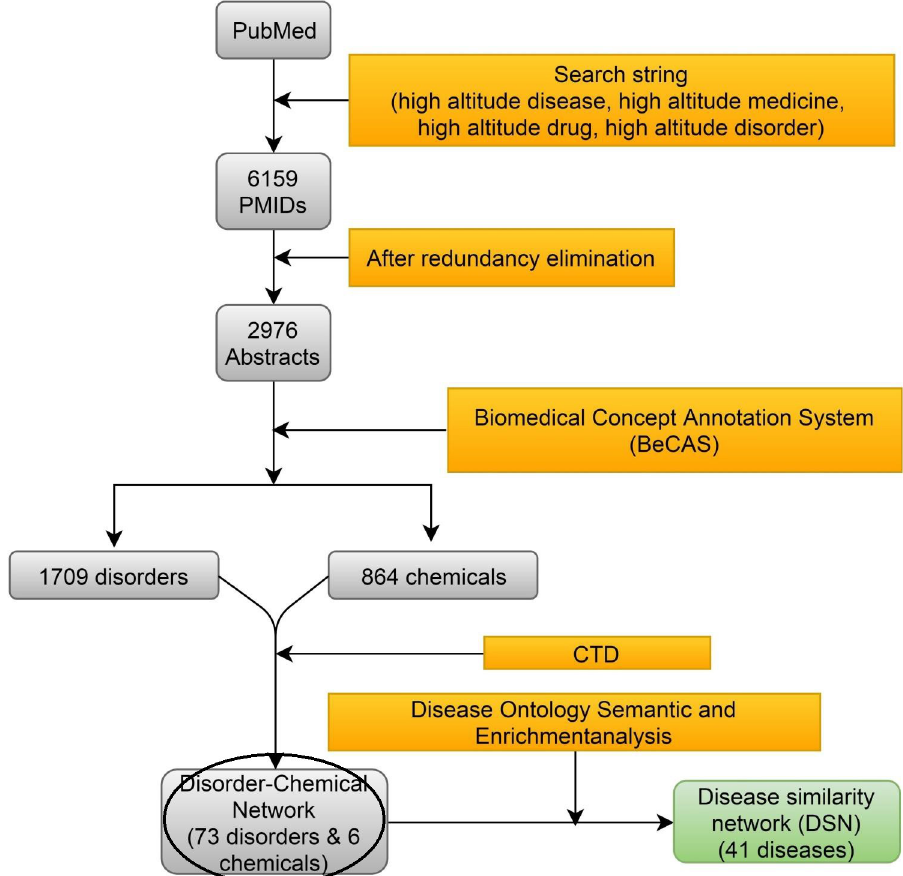
Fig 1. The workflow pipeline followed to build the disease similarity network (DSN) of high altitude related diseases. Step 1: PubMed Central was queried for high altitude related abstracts. Step 2: All high altitude abstracts were collected and redundancies were removed. Step 3: The Biomedical concept annotation system (BeCAS) was used to extract the high altitude related diseases/disorders and chemicals from the collected abstracts. Step 4: The relations among diseases and chemicals from Comparative Toxicogenomics Database (CTD) were used to construct the Disorder-Chemical Network. Step 5: Disease ontology based semantic similarity-based score was used to construct the Disease similarity network